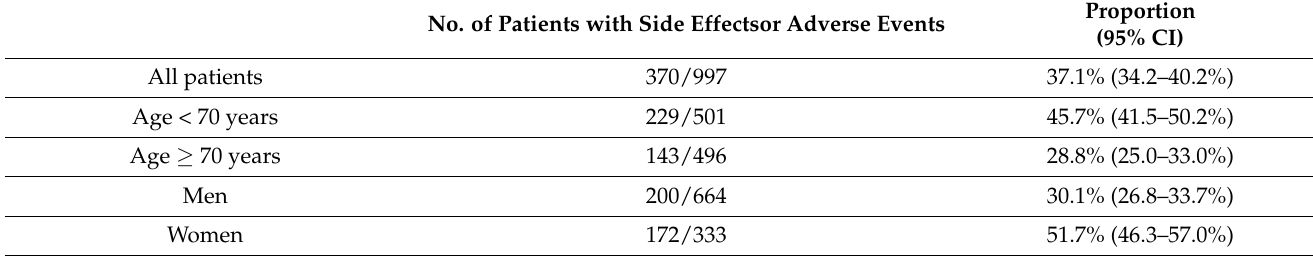
Figure 2. Local and systemic side effects and adverse events after the first and the second dose of BTN162b2 vaccine in cancer patients treated at our institution. GI: gastrointestinal. Table 2. Proportion of side effects and adverse events according to all the selected variables after the first vaccine dose (A) and after the second vaccine dose (B). A No. of Patients with Side Effectsor Adverse